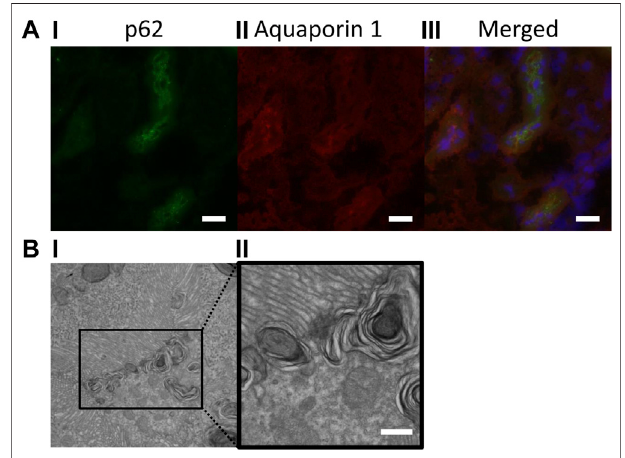
FIGURE 2 | p62-positive spots and multi-lamellar bodies (MLBs) accumulated under or on the brush border of proximal tubular cells. (A) Immuno fl uorescent images (400 × magni fi cation); (I) p62 (green), (II) aquaporin-1 (red), and (III) merged, bars: 20 μ m; (B) electron microscopic images ( i : 1,500 × magni fi cation and ii : 6,000 × magni fi cation); MLBs in proximal tubular cells, bar: 500 nm.